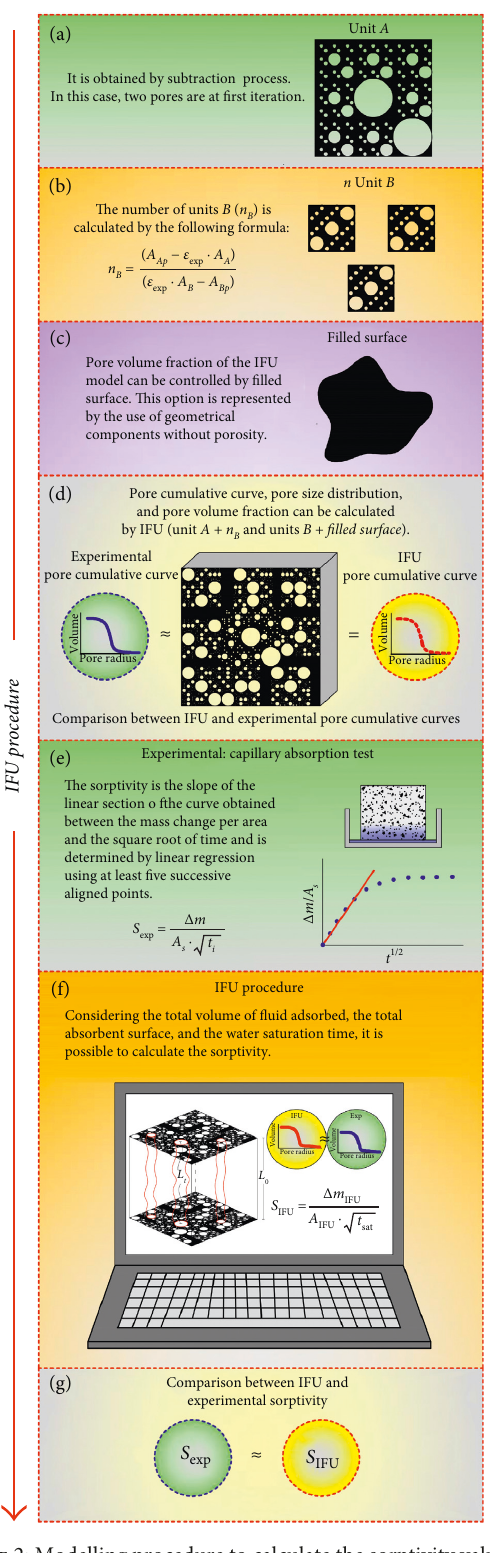
Figure 2: Modelling procedure to calculate the sorptivity value. (a) to (c) IFU construction intermingling different types and numbers of the Sierpinski carpets and solid surface; (d) comparison between experimental and IFU pore cumulative curves; (e) and (f) calcu- lation of sorptivity applying the fractal expression; (g) comparison between experimental and model sorptivity